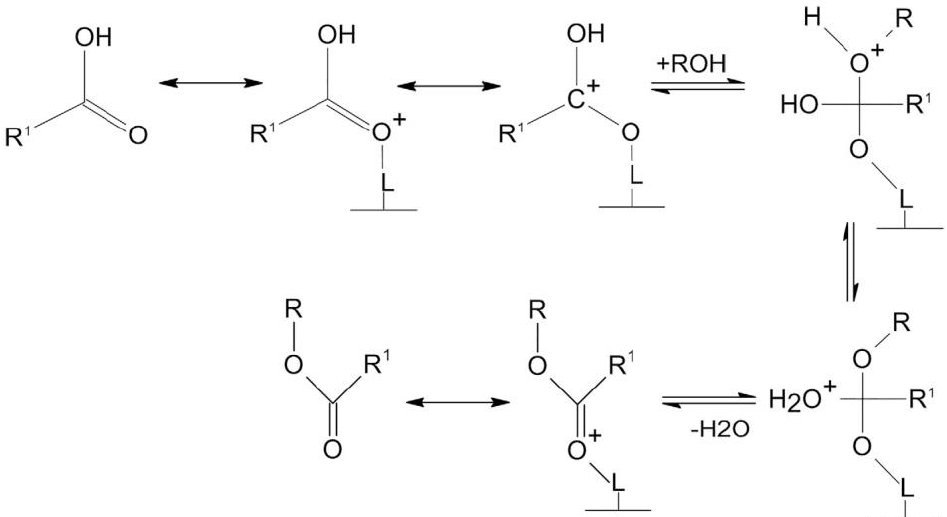
Figure 6. Heterogeneous acid catalysis reaction mechanism (L, active site). Data adapted from [119], published by John Wiley & Sons, 2021.